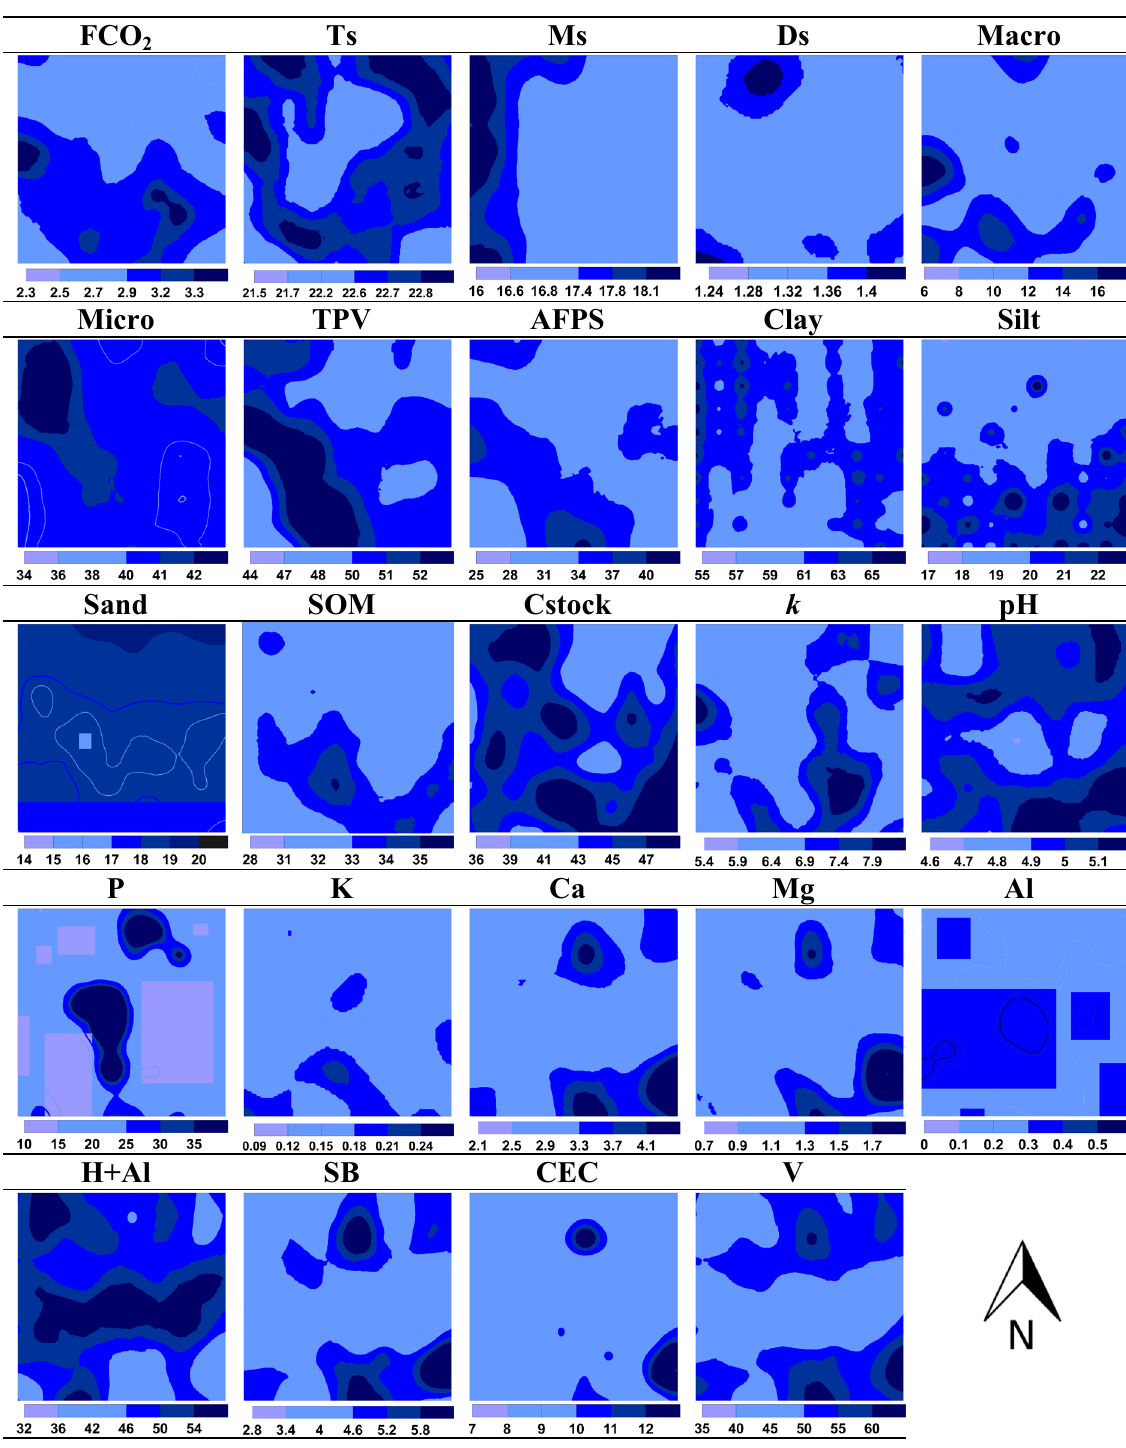
Figure 1. Spatial distribution of soil attributes. FCO 2 = soil CO 2 emission (µmol m −2 s −1 ); Ts soil temperature (°C), Ms soil moisture (%), Ds soil bulk density (g cm −3 ), Macro macroporosity (%), Micro microporosity (%), TPV total pore volume (%), AFPS air-filled pore space (%), Clay clay content (%), Silt silt content (%), Sand sand content (%), SOM soil organic matter (g dm −3 ), Cstock soil carbon stock (Mg ha −1 ), k soil carbon decay constant (d −1 × 10 −4 ), P phosphorus content (mg dm −3 ), K exchangeable potassium content (cmol c dm −3 ), Ca exchangeable calcium content (cmol c dm −3 ), Mg exchangeable magnesium content (cmol c dm −3 ), Al aluminum content (cmol c dm −3 ), H + Al potential acidity (cmol c dm −3 ), SB sum of bases (cmol c dm −3 ), CEC cation exchange capacity (cmol c dm −3 ), V base saturation